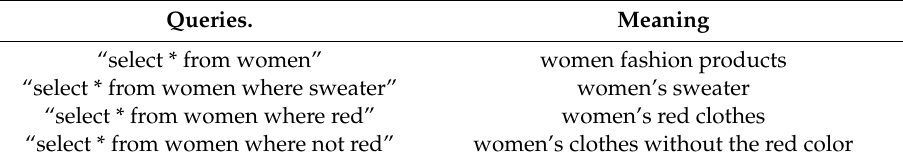
Table 4. Query examples using the pseudo SQL form (the syntax can be modified). Queries.